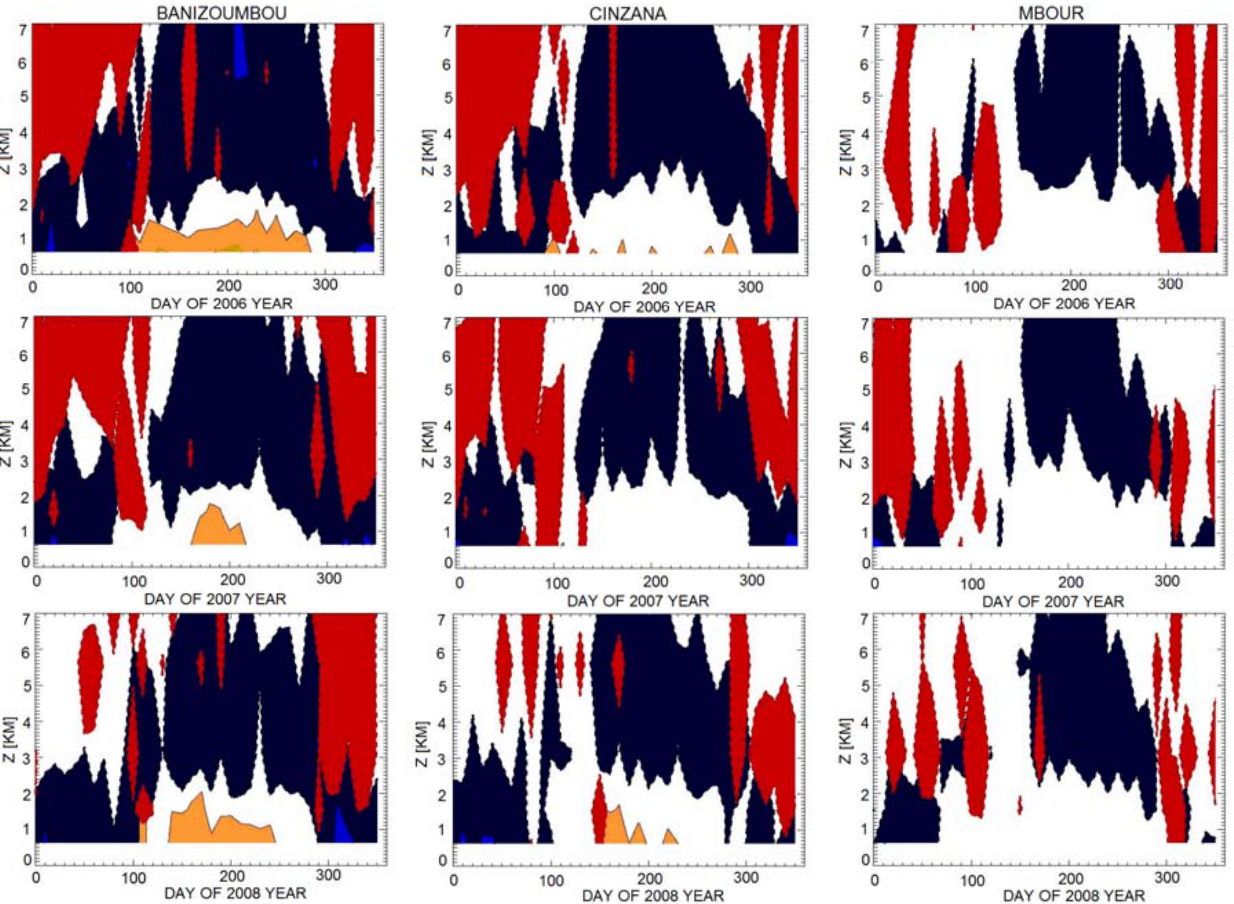
Fig. 10. Time-height evolution for air masses originating in the Desert region (blue) and the Ocean region (orange) as well as the air masses encountering Forest fires observed by AATSR (red). Number of trajectories is averaged over 10 days. Units are arbitrary.